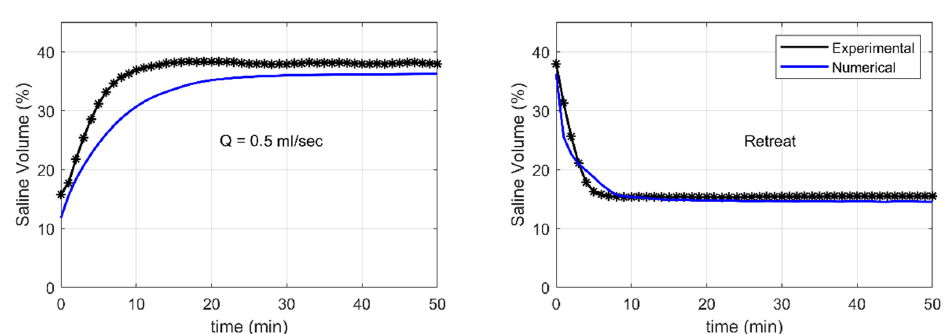
Figure 4. Transient experimental and numerical values of the saline volume fraction in the fractured-right aquifer, under an abstraction rate of 0.5 mL/s ( left ) and during the saltwater retreat phase ( right ).